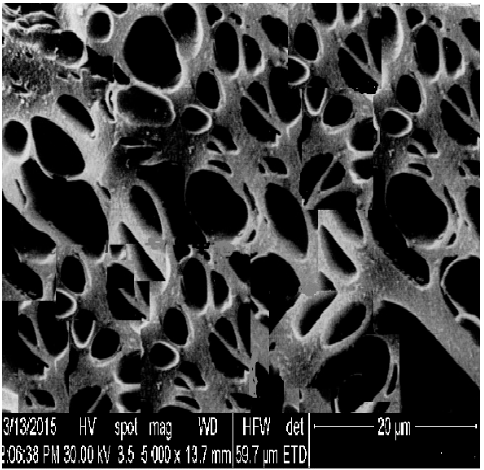
Figure 4. SEM micrographs of activated charcoal.